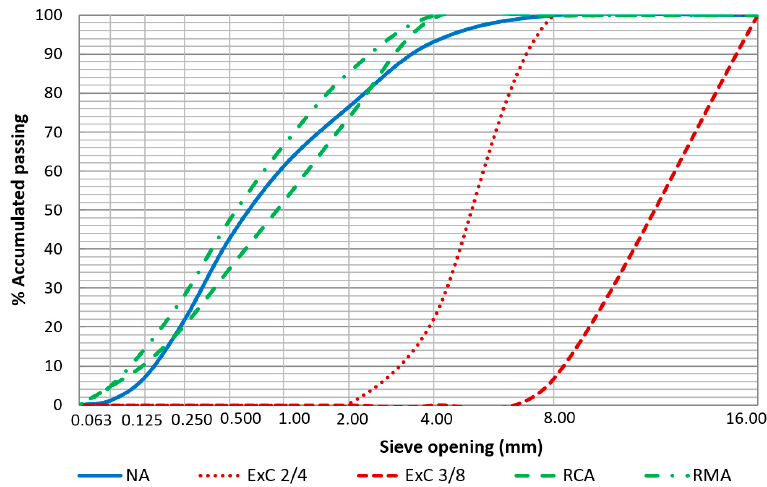
Figure 1. Particle size distribution of raw materials.